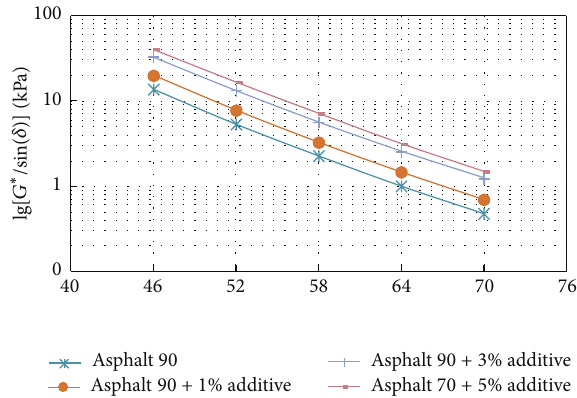
Figure 6: Rutting factors of 90# virgin asphalt and WMA binder versus temperature.